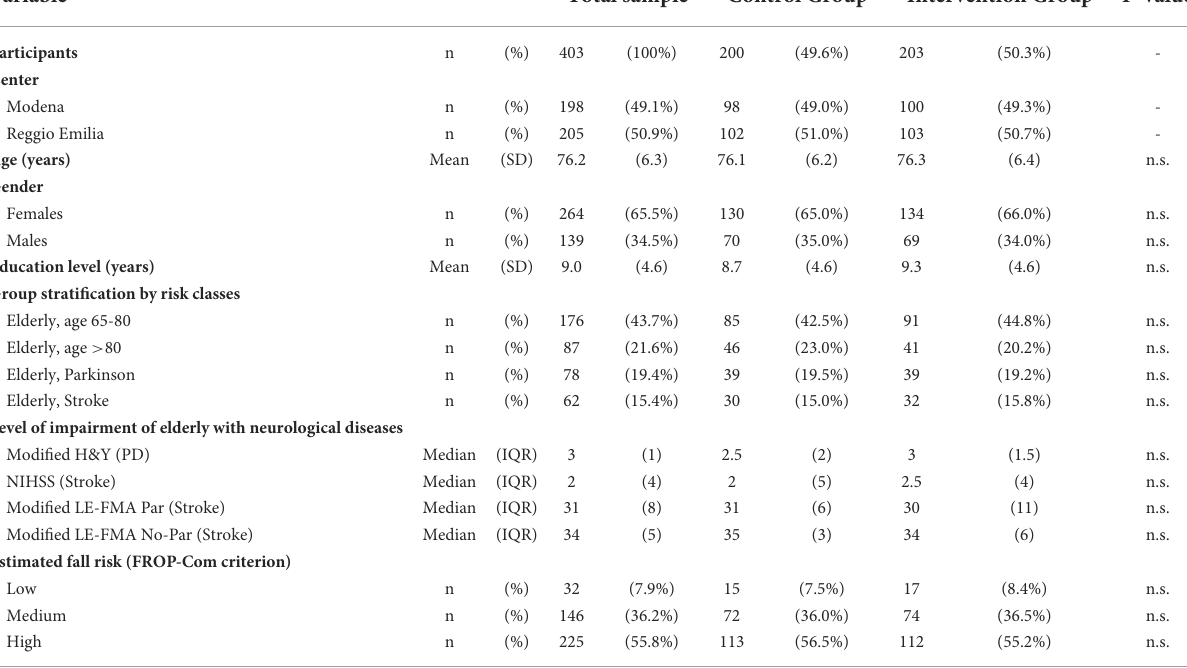
TABLE 2 Clinical and demographic sample